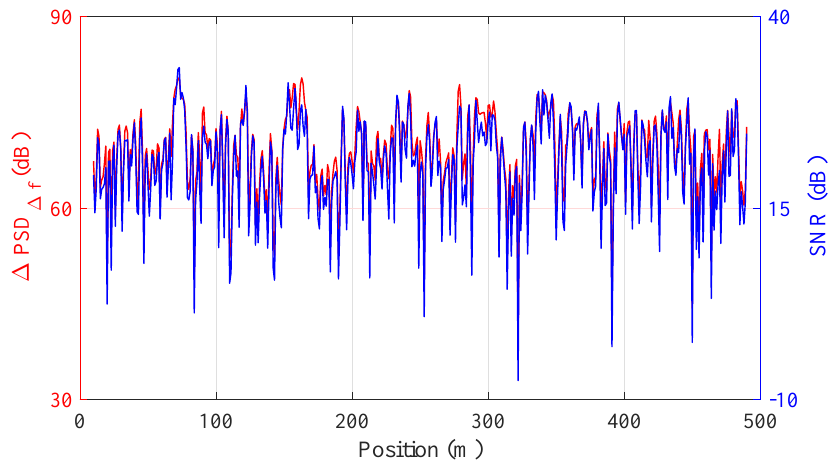
Figure 7. Measured relative PSD at heterodyne frequency (left vertical axis) and the SNR (right vertical axis) over position.